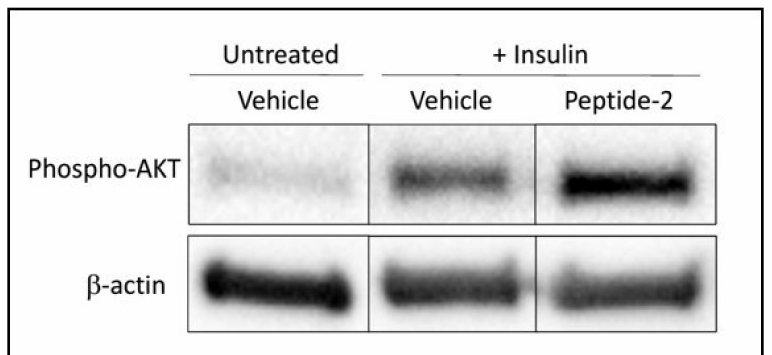
Figure 2. TNFSF14 Peptide 2 treatment promotes insulin sensitivity. Representative immunoblot showing Peptide 2 treatment (20 µ g/mL; 48 h) promotes insulin signalling in L6 skeletal muscle myotubes as indicated by increased expression of phospho-AKT. Beta-actin served as a house keeping protein.